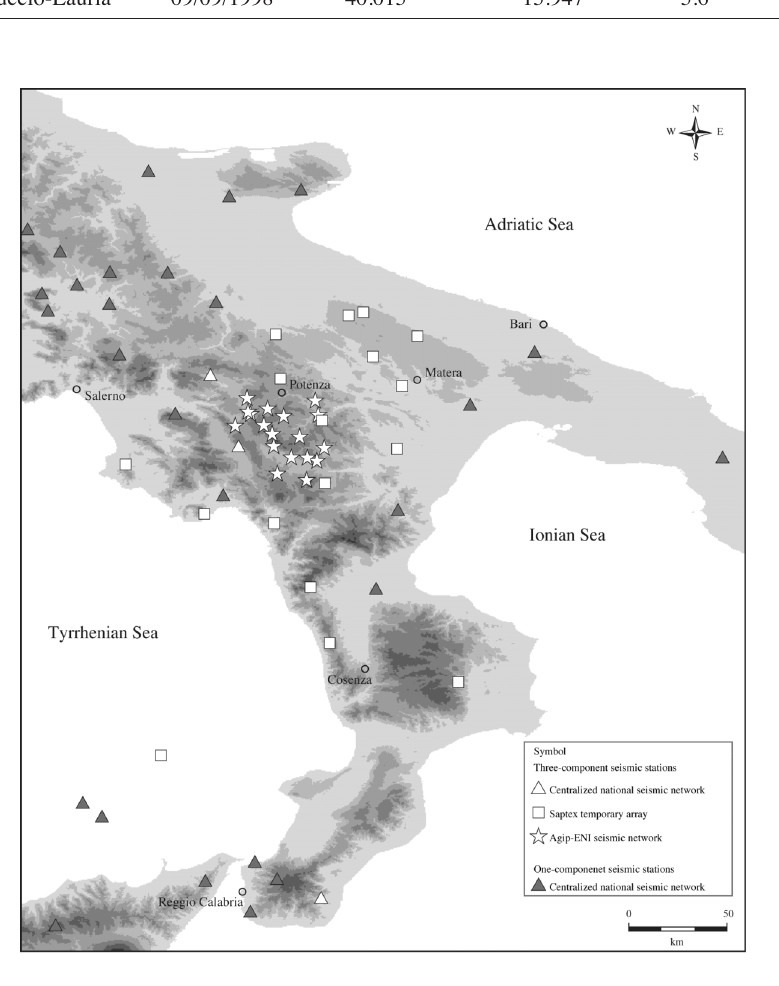
Fig. 2. Map of seismic stations used in this study. White triangles are the three-components permanent stations of the Italian National Seismic Network (RSNC), white square are the three-components temporary stations of the SAPTEX array, white stars are the short-period three-components stations of the Eni-Agip local network in the Agri Valley area and dark-grey triangles are the one-component stations of the